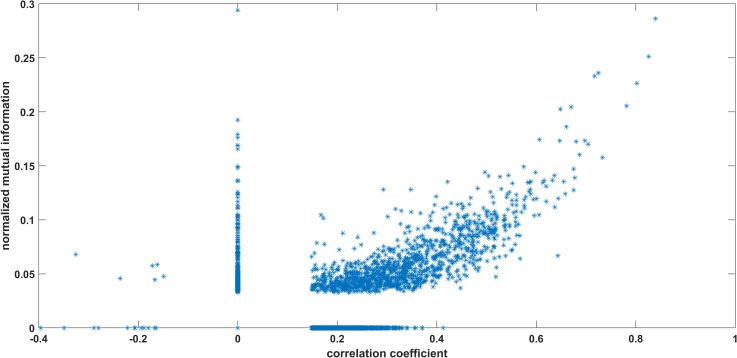
Correlation coefficient versus mutual information: daily returns for the year 2014.On x-axis we have correlation coefficients and on y-axis we have normalized mutual information for all 3916 pairs. (a), (b) and (c) correspond to pre-election, election and post-election periods.